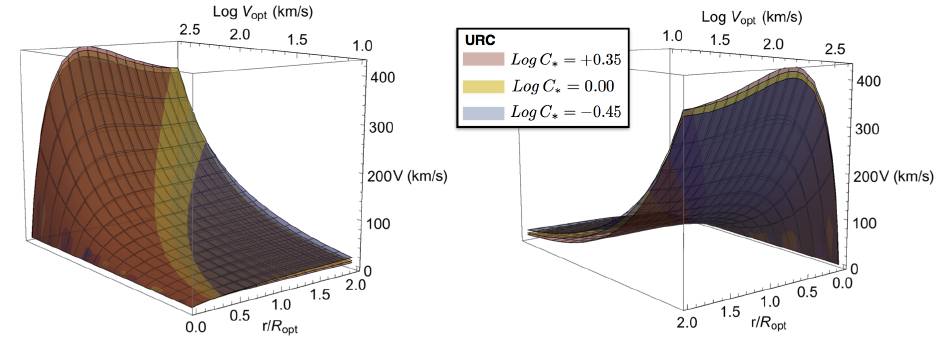
Figure 23. URC-LSB in physical units for: low ( Log C ∗ = − 0.45), standard ( Log C ∗ = 0.00) and high ( Log C ∗ = + 0.35) stellar compactness, respectively in blue, yellow and red . Image reproduced from [38] (Figure